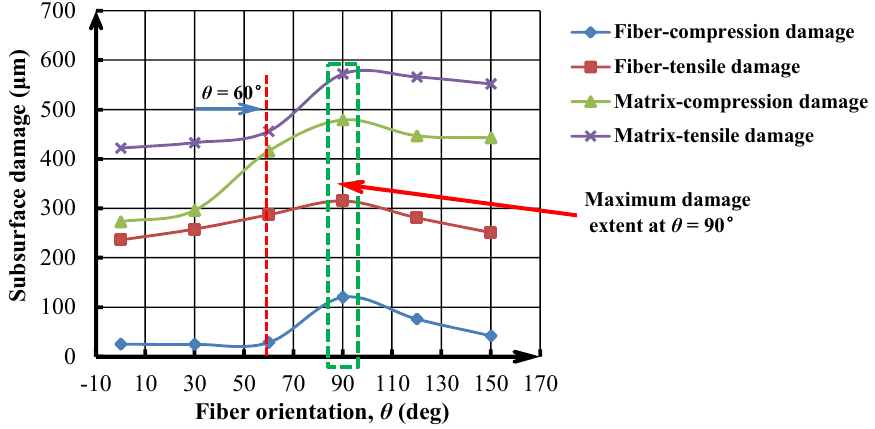
Figure 17. Fiber/matrix damage extent versus fiber orientation ( θ ) ( v c = 40 m/min and f = 0.2 mm/rev).